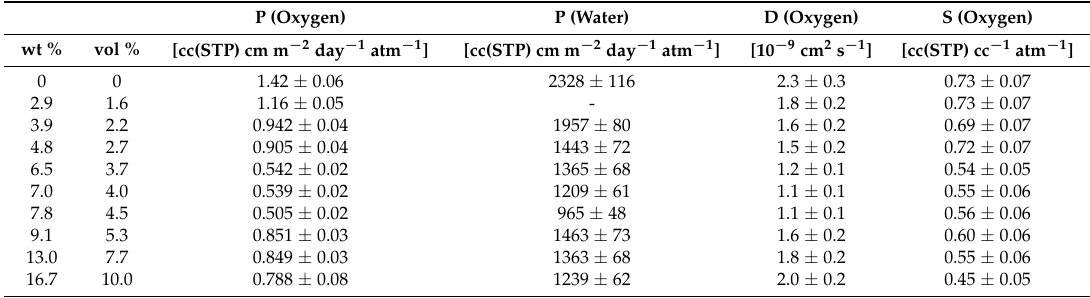
Figure 18. Relative oxygen permeability as a function of vol % of SNT in PIPAA-PM/SNT nanocomposite films. The curves represent theoretical predictions of composites filled with fillers exhibiting different geometries: spherical (1), disks with r/h ј 10 (2), and rods with L/d ј 1 (3), 5 (4) and 20 (5). Note that subscripts NC and M in the y-axis legend represent PIPAA-PM/SNT and PIPAA-PM, Table 1. Oxygen and water vapor barrier characteristics of polyimide/SNT nanocomposites [130]. respectively, as described in the text [4].